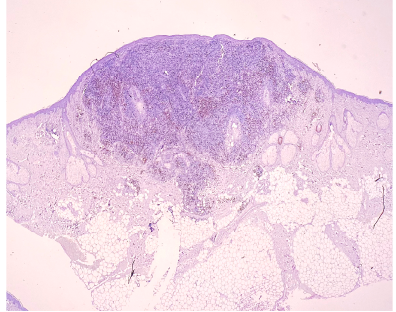
Figure 7. CD8 staining. Magnification 20×.